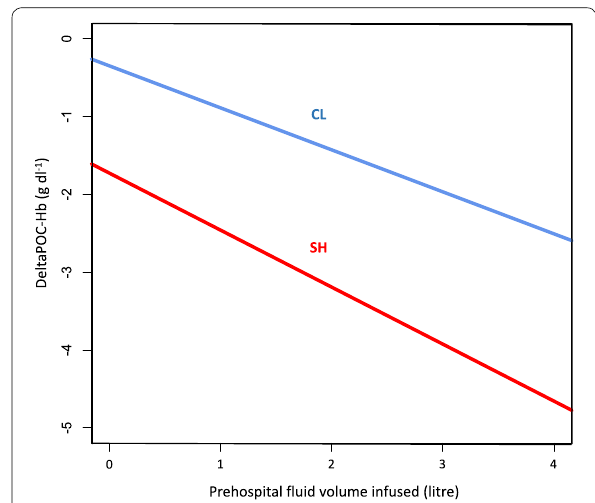
Fig. 3 Relationship between the Hb drop from prehospital phase to hospital admission measured by POC